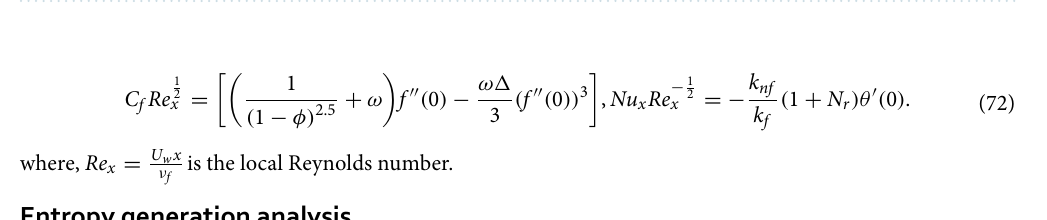
Table 3. Comparison in terms of - θ Ec = 0 , S = 0 and Bi = 0